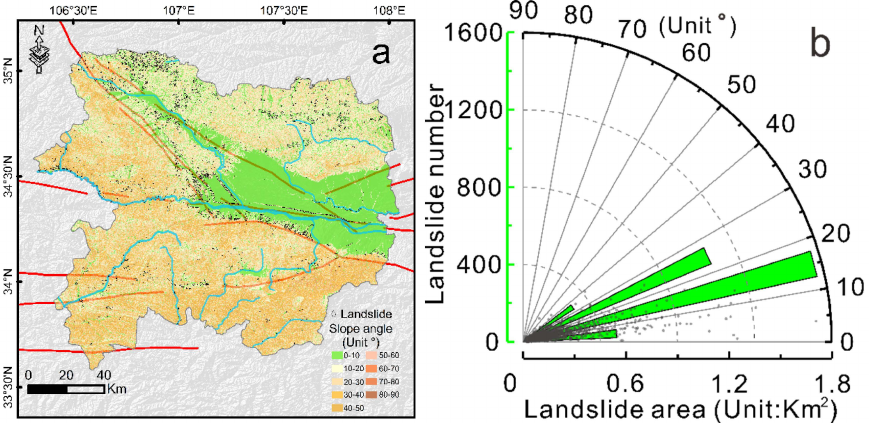
Figure 8. Stream distribution in the study area. The illustration in the upper right corner indicates the ranked distance interval from stream.